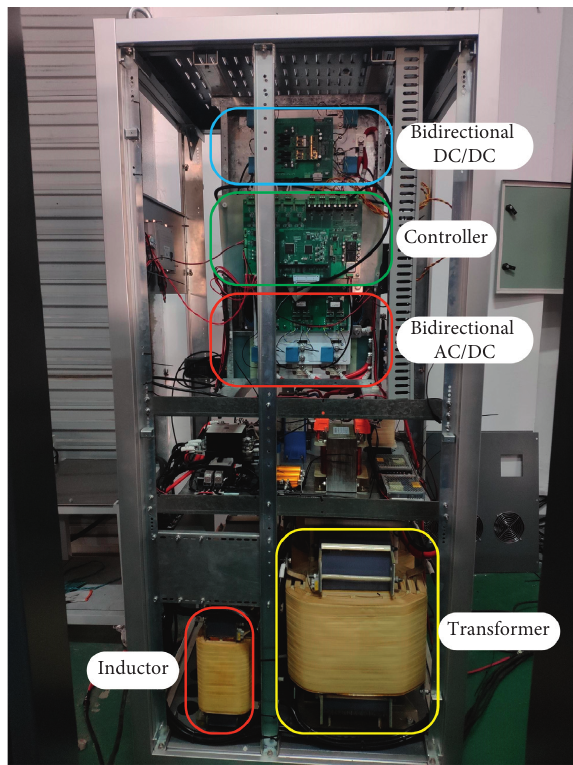
Figure 15: The photo of experiment platform.